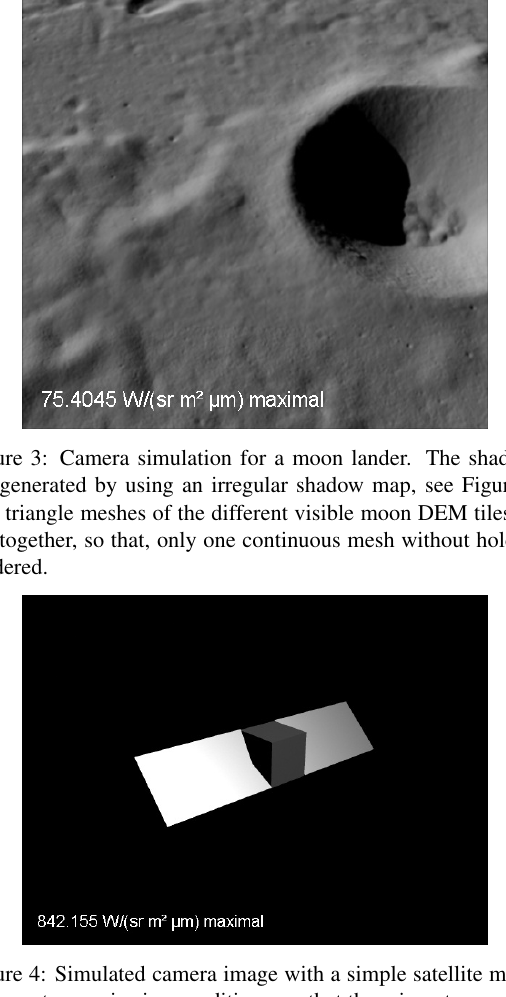
Figure 4: Simulated camera image with a simple satellite model under extreme viewing conditions, so that there is a strong spec- ular reflection. The middle part of the satellite is modeled as a Lambertian reflector and the panels are specular